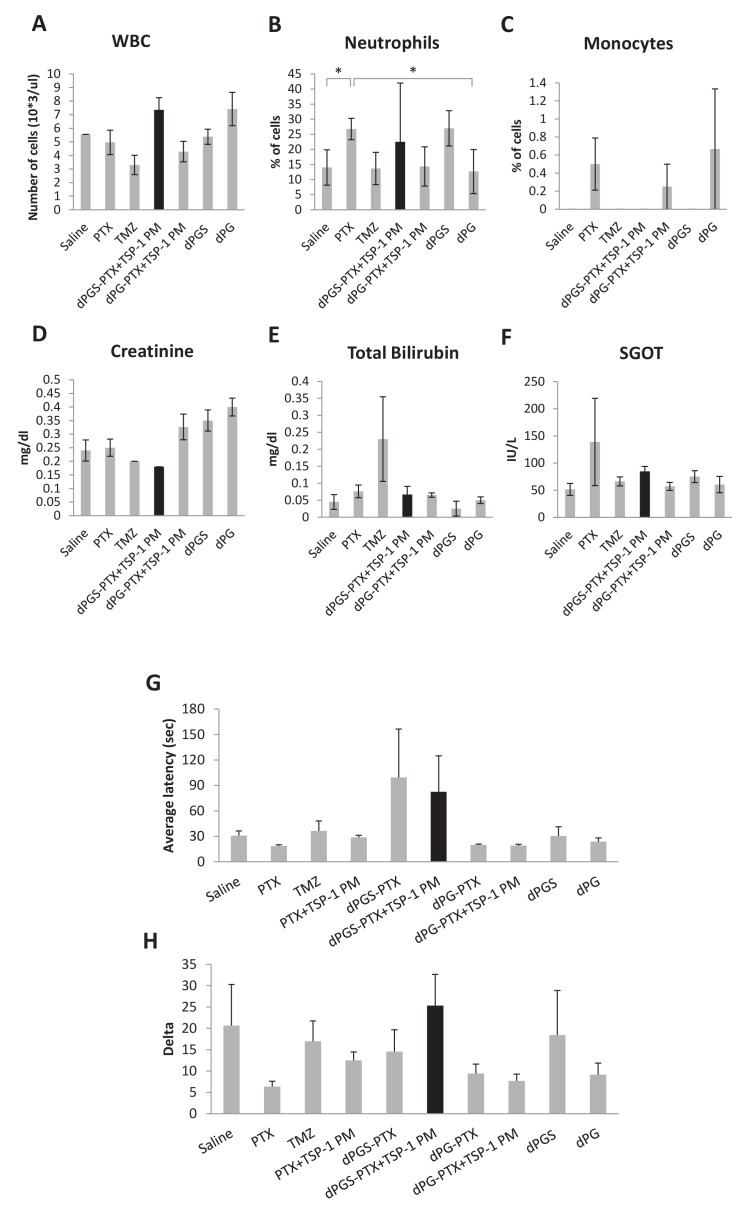
Combination treatment of dPGS-PTX and TSP-1 PM did not induce systemic toxicity.(A–F) Blood was drawn from glioblastoma tumor-bearing mice (n = 5–8) following treatments and was analyzed for blood count (A–C) and biochemistry analysis (D–F). WBC, white blood cells; SGOT, serum glutamic oxaloacetic transaminase. (G) Average latency of mice to fall from the Rotarod. Data represent mean ± s.e.m. (n = 2–4). (H) Delta of latency to fall from a Rotarod between their first and last performance. Data represent mean ± s.e.m. (n = 2–4). *p<0.05.10.7554/eLife.25281.023Figure 8—figure supplement 1—source data 1.Raw data of blood count and biochemistry analysis.10.7554/eLife.25281.024Figure 8—figure supplement 1—source data 2.Raw data of mice Rotarod experiments.